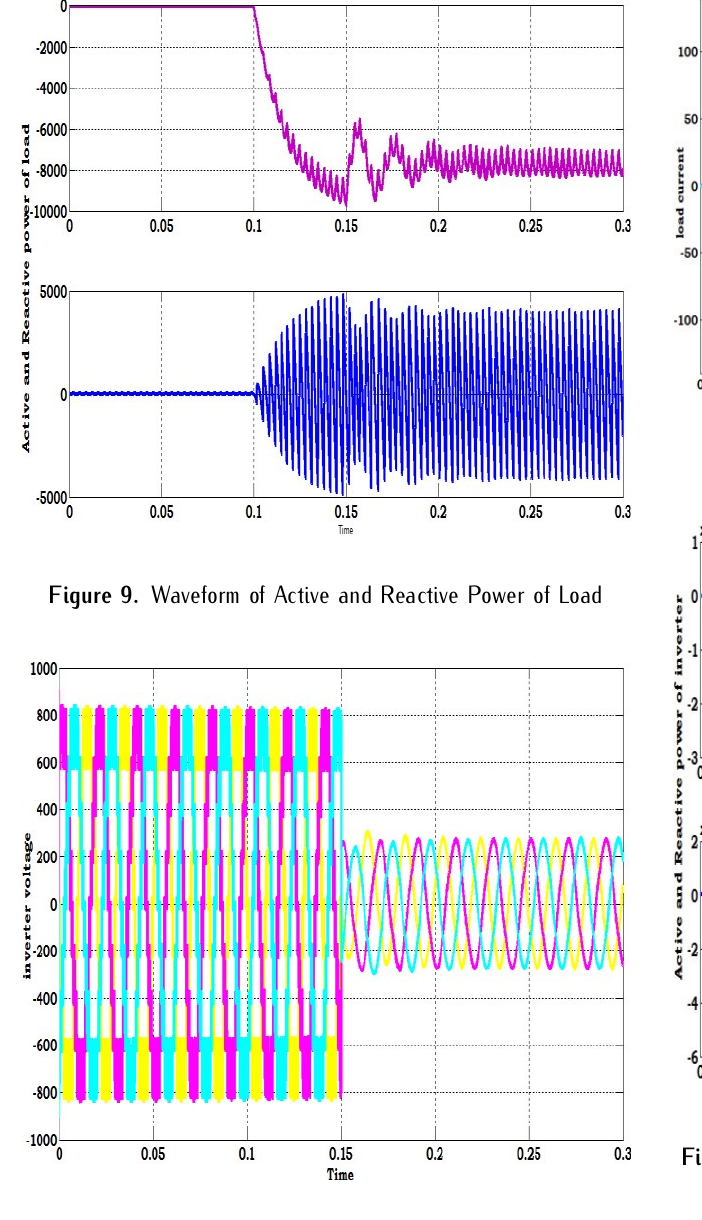
Figure 10. Waveform of Inverter Voltage